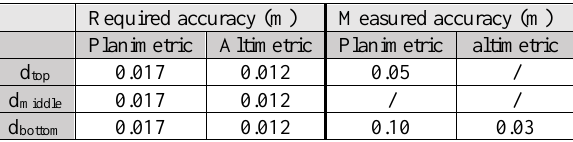
Table 4. The required accuracy in comparison with the measured accuracy for the sub-foundation. The accuracy in altimetry couldn't be checked because the sub-foundation isn't finished.